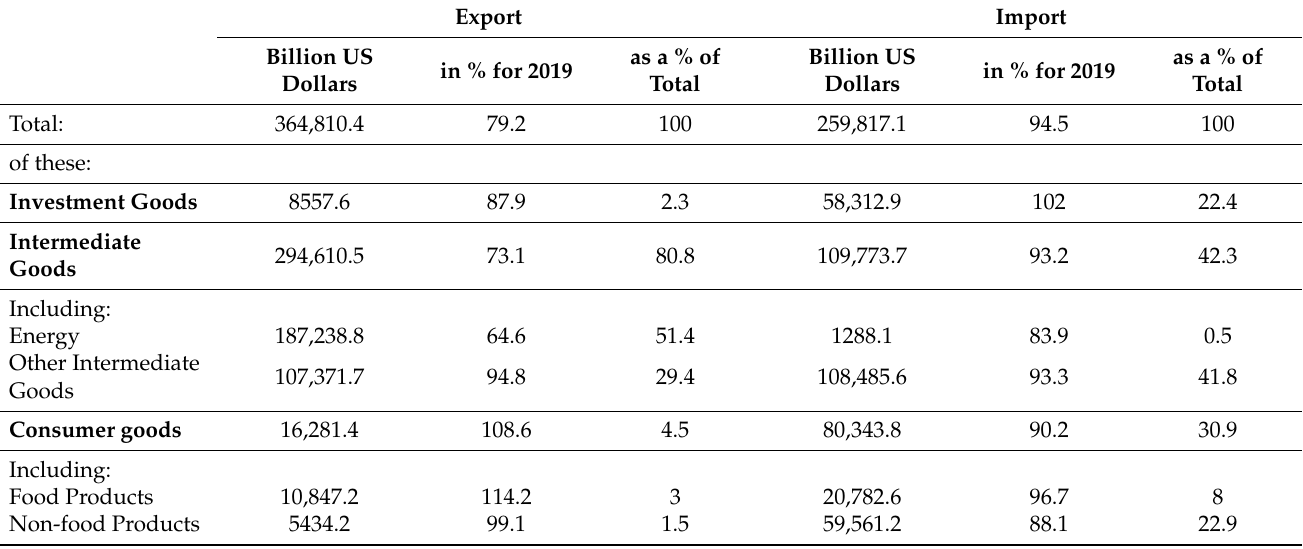
Table 2. Structure of EAEU exports and imports in foreign trade. Export